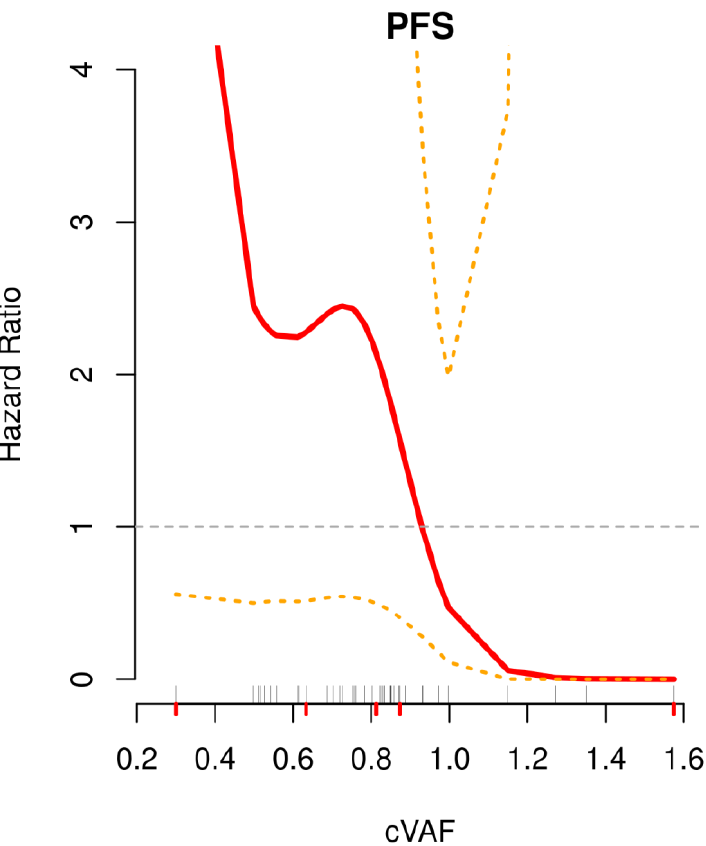
Figure 3. Non-linear modeling of the impact of cVAF on PFS using smoothing splines. Shown in red is the association of the hazard ratio with the cVAF with 95% confidence intervals (orange). Grey lines above the x-axis represent the single cVAF values, red lines below the x-axis the five-number summary (min, 25th percentile, median, 75th perc., max).